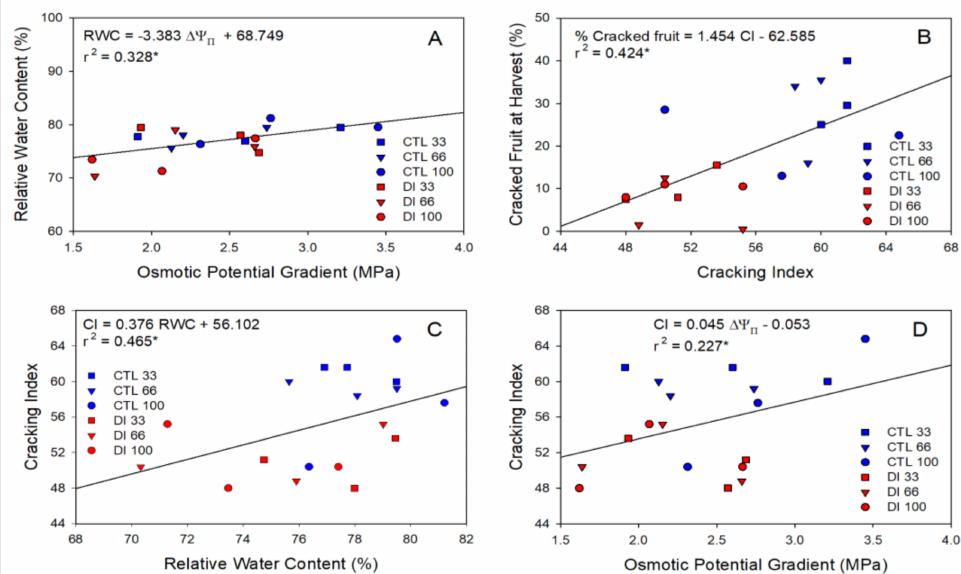
Figure 7. Linear regression between the fruit osmotic potential gradient ( ∆Ψ π ) and the fruit relative water content (RWC) ( A ), the cracking index (CI) assessed in the laboratory and the proportion of fruit cracked at harvest ( B ), the fruit relative water content and the cracking index ( C ), and the osmotic potential gradient and the cracking index ( D ) for the two irrigation treatments: CTL (full irrigated treatment; blue) and DI (deficit irrigation treatment; red), and the three levels of crop load: low (33% square), medium (66% triangle), and high (100% circle). Each point represents one replicate (tree). * indicates a significant relationship between the studied variables at p <